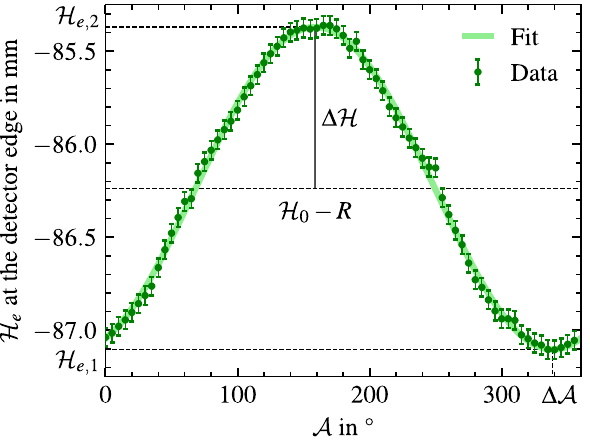
Fig. 8 Horizontal stage position at which the detector edge is deter- mined, H e , as a function of the rotational stage angle A . The misalign- ment quantities Δ H and Δ A are indicated. The error bars correspond to the uncertainties obtained from the fits to determine H